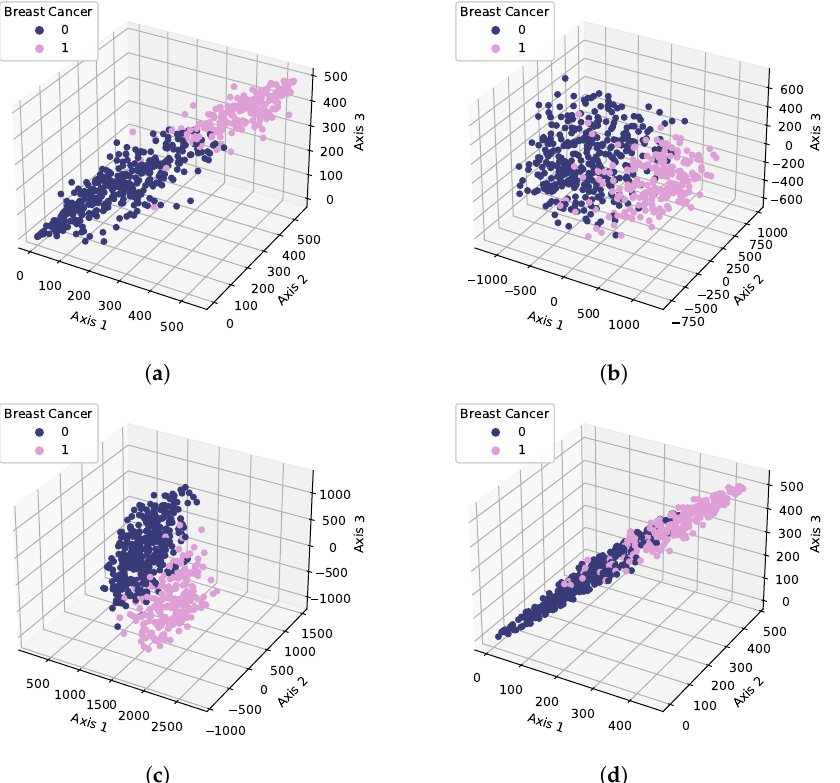
Figure 7. Feature space visualization using feature selection techniques: ( a ) Chi2, ( b ) PCA, ( c ) SVD, and ( d ) original. Table 14. Comparison of classification accuracy with state-of-the-art approaches for breast cancer